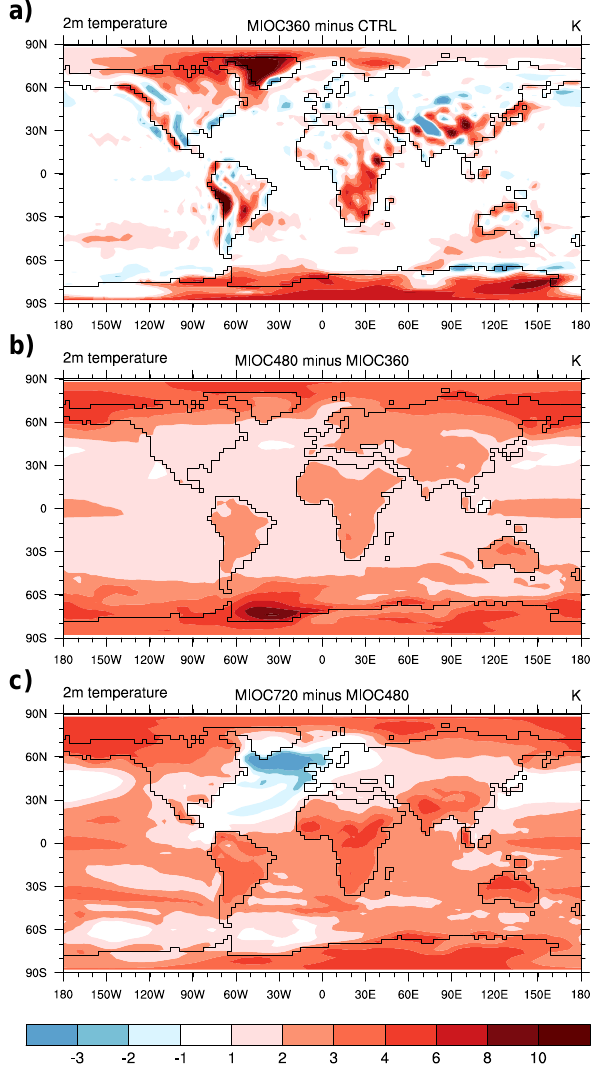
Fig. 3. Differences in 2m air temperature between (a) MIOC360 and CTRL, (b) MIOC480 and MIOC360, and (c) between MIOC720 and MIOC480 (in